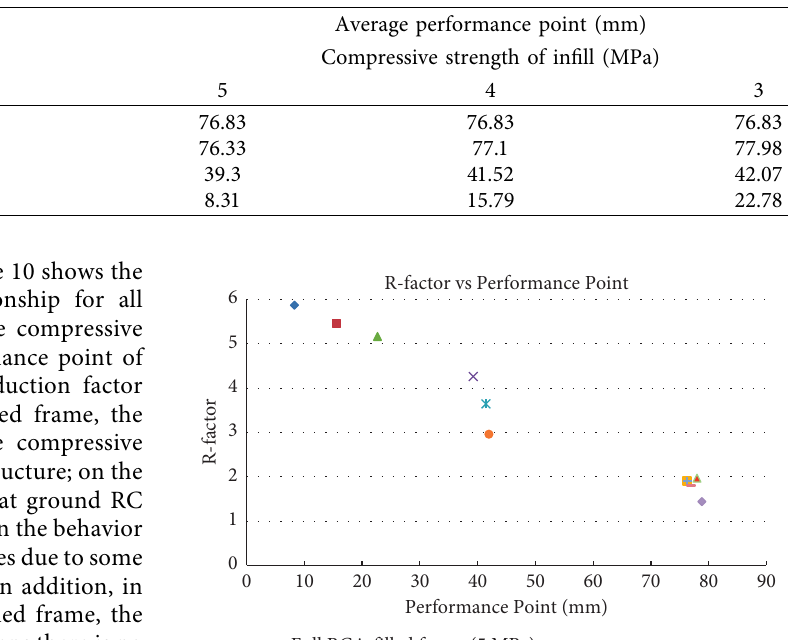
Figure 9: Comparison of the time period from all structural models. Table 6: Comparison of the performance point for all structural